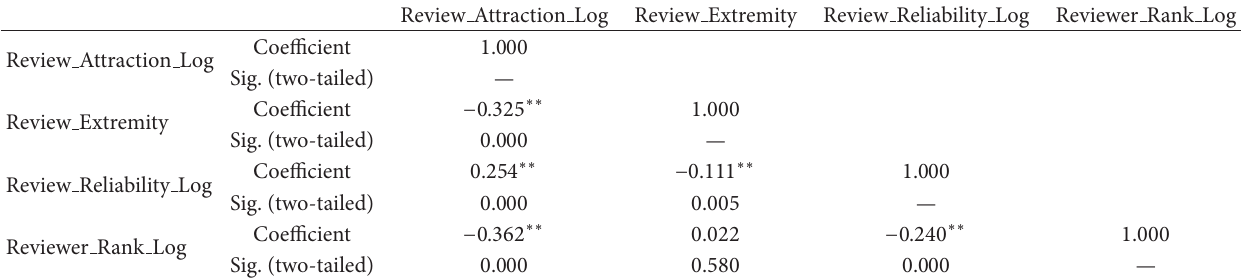
Table 5: Correlation of variables in review attraction